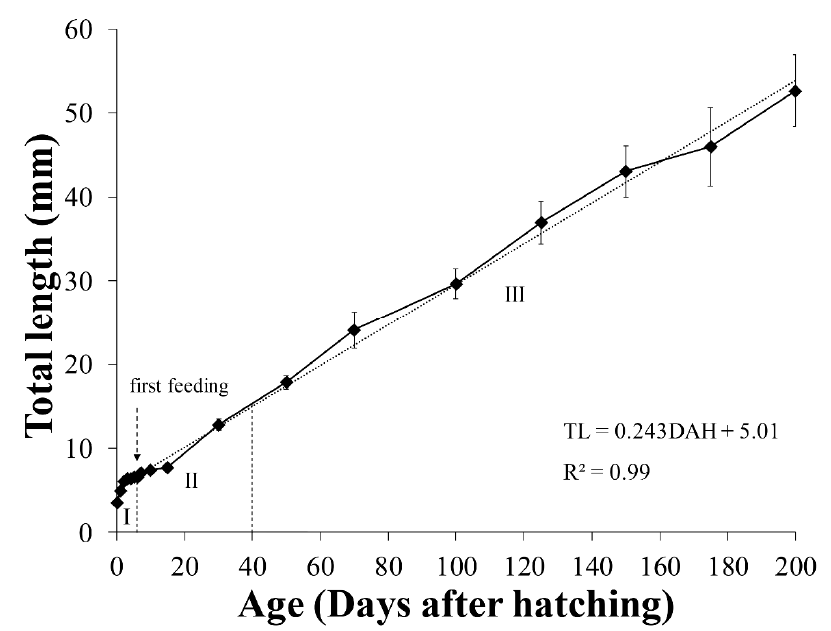
Figure 3. Growth of total length in Anguilla japonica from 0 to 200 DAH (stage I: yolk sac larvae; stage II: pre-leptocephalus; stage III: leptocephalus). Values are means ± SD. Abbreviations: DAH, days after hatching; TL: total length.